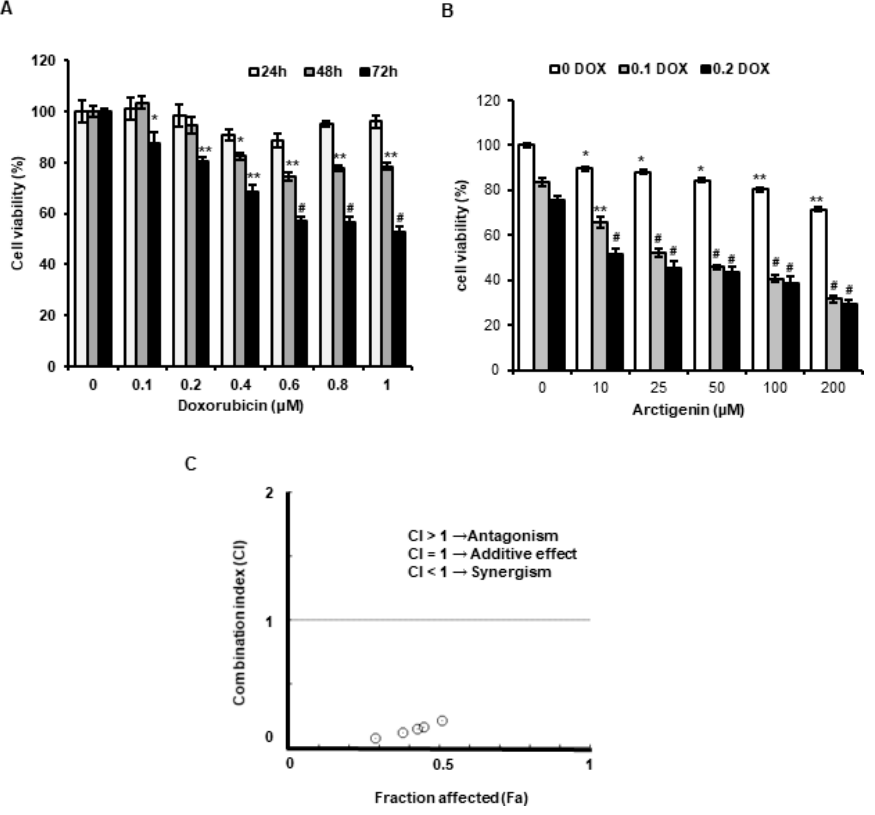
Figure 1. E ff ect of arctigenin (ATG) co-treatment on doxorubicin (DOX)-induced cytotoxicity in MDA-MB-231 cells. ( A ) Cells were incubated in Dulbecco’s Modified Eagle’s medium (DMEM)